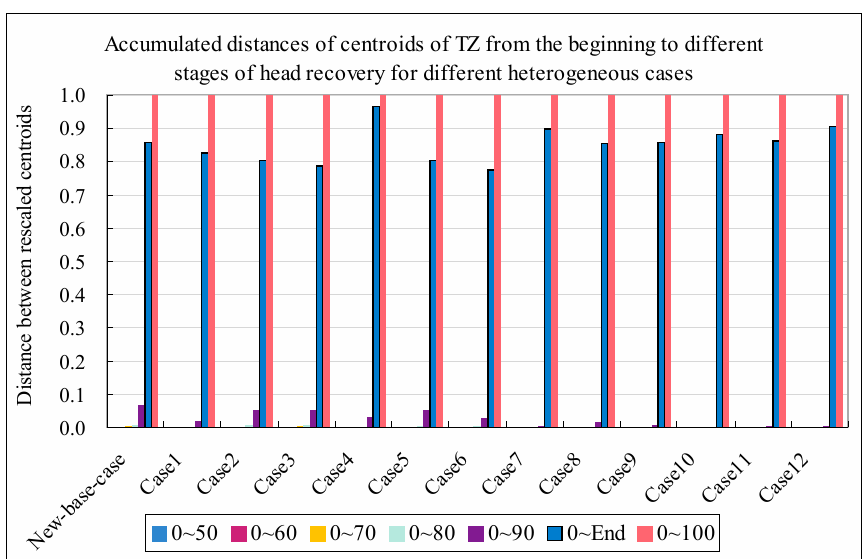
Figure 10. Accumulated distances of the rescaled centroids from the beginning of recovery to different stages of head recovery for different heterogeneous cases (note: “New base case” in the figure denotes the new base case).